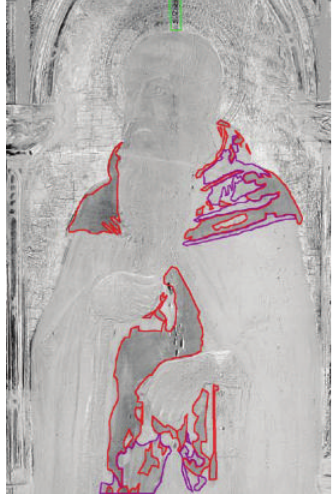
Figure 3: Image acquired with IR2 band with additional informa- tion and features (indicated with red and purple color) provided respect to the visible spectrum (RGB and Panchromatic).